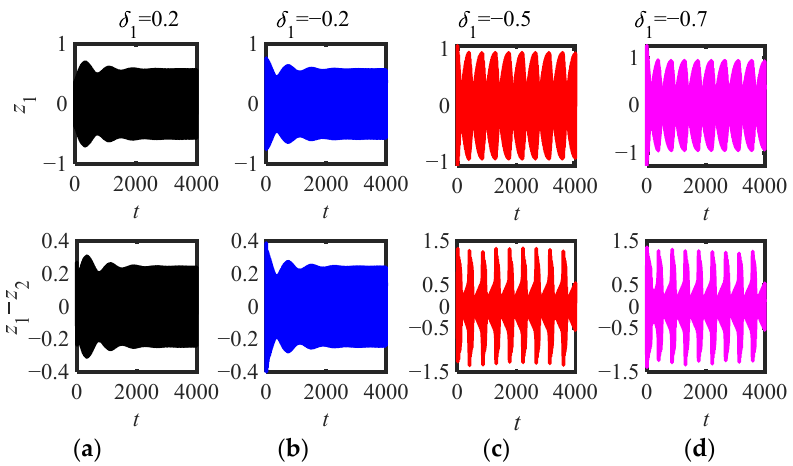
Figure 14. Time-domain response of (5) (parameters in Figure 11a m 2 = 0.3, μ = 1.9, κ = 0.11): ( a ) δ 1 = 0.2, ( b ) δ 1 = − 0.2, ( c ) δ 1 = − 0.5, ( d ) δ 1 = −